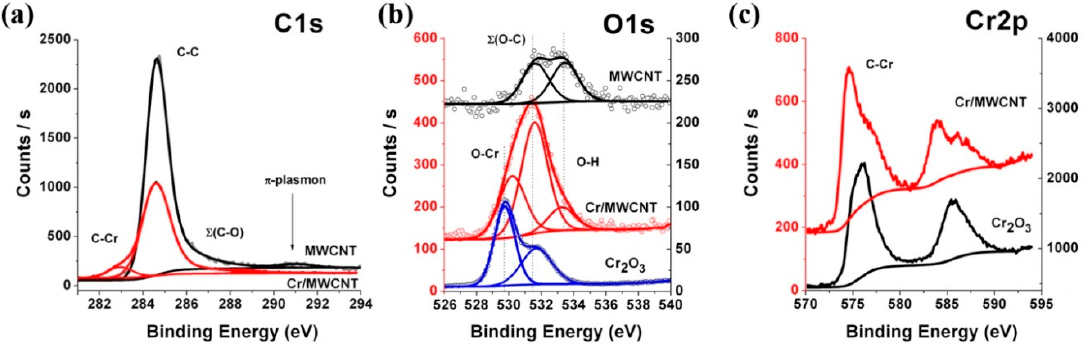
Figure 11. XPS ( a ) C1s, ( b ) O1s and ( c ) Cr2p spectra of the initial MWCNTs, Cr/MWCNTs and trioxide Cr 2 O 3 ; ( d ) XPS Cr 2 O 3 O1s spectrum is reduced by a factor of chromium trioxide Cr 2 O 3 ; ( d ) XPS Cr 2 O 3 O1s spectrum is reduced by a factor of 10.